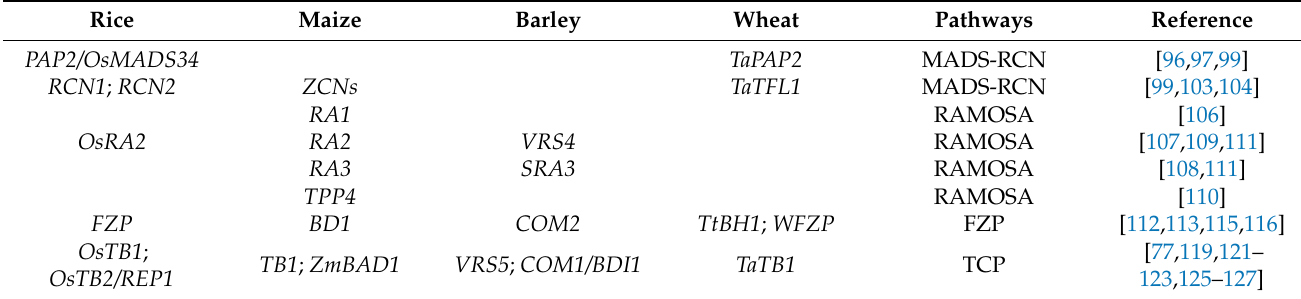
Table 2. Key regulators involved in IM differentiation and specification in rice, maize, barley and wheat. Rice Maize Barley